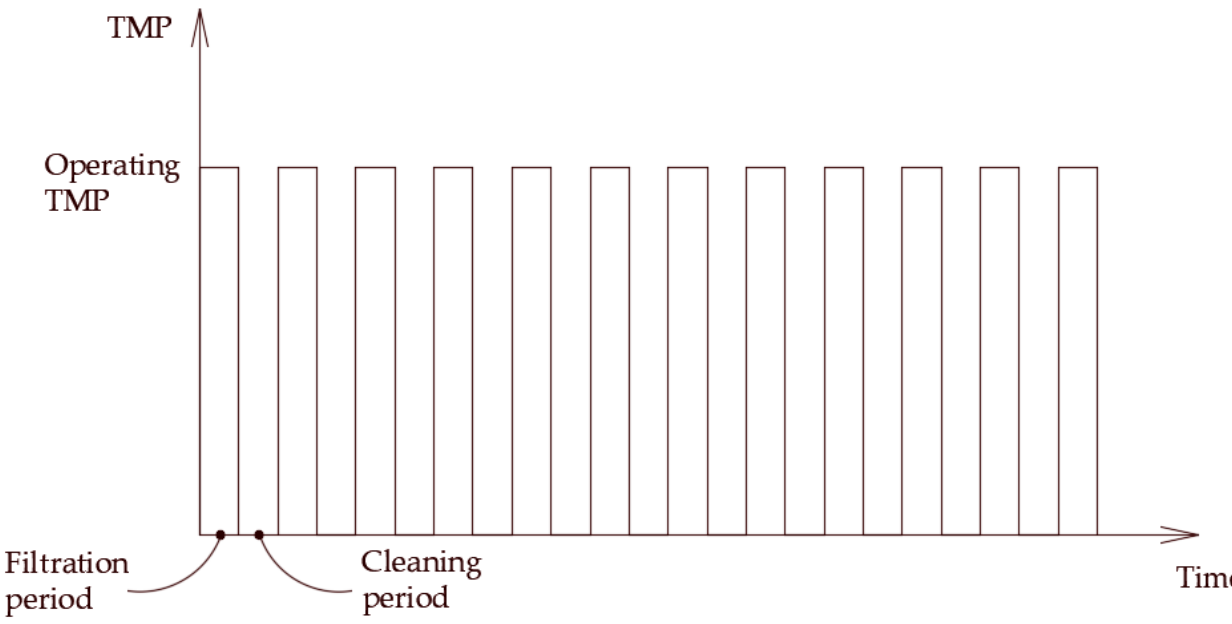
Figure 2. Schematic representation of the periodic feed pressure.